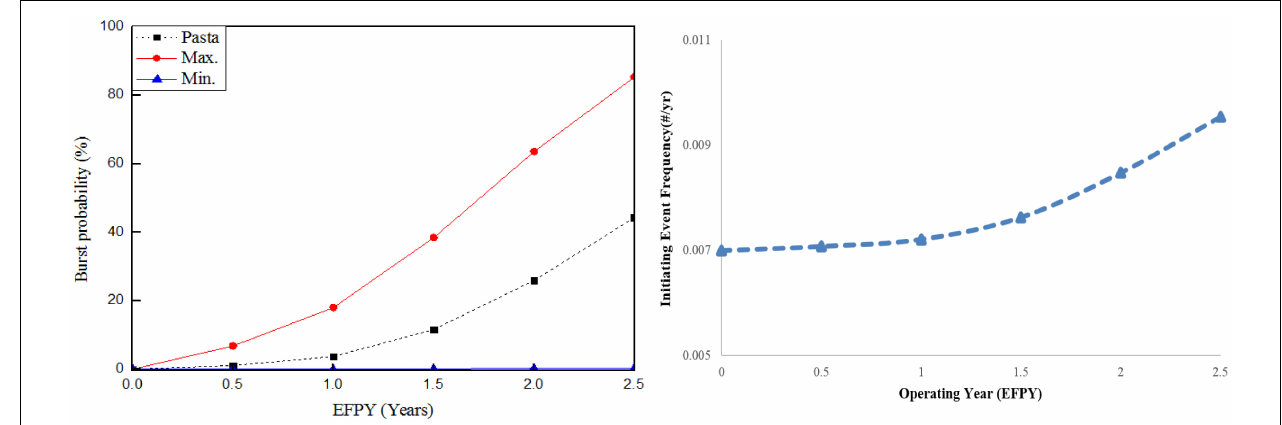
FIGURE 1 | Forecast for frequency of steam generator tube rupture